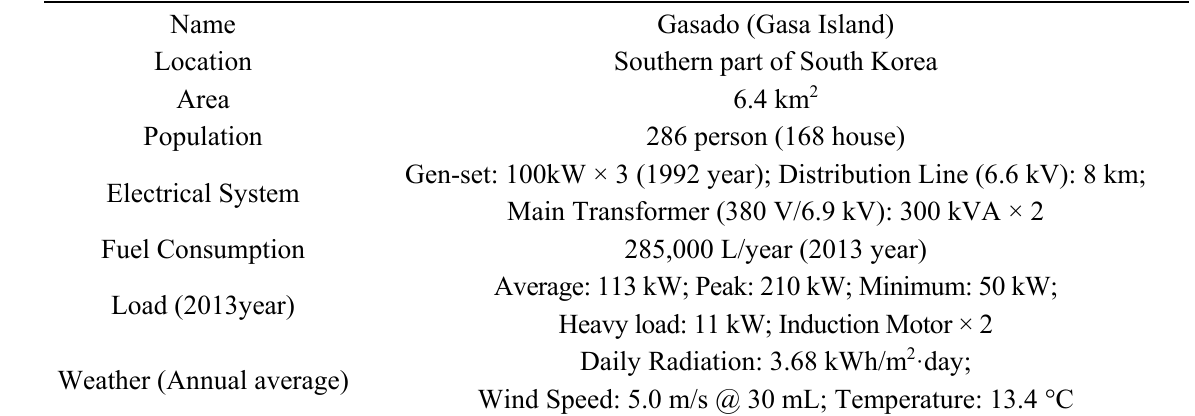
Table 2. Overview of the Test Island